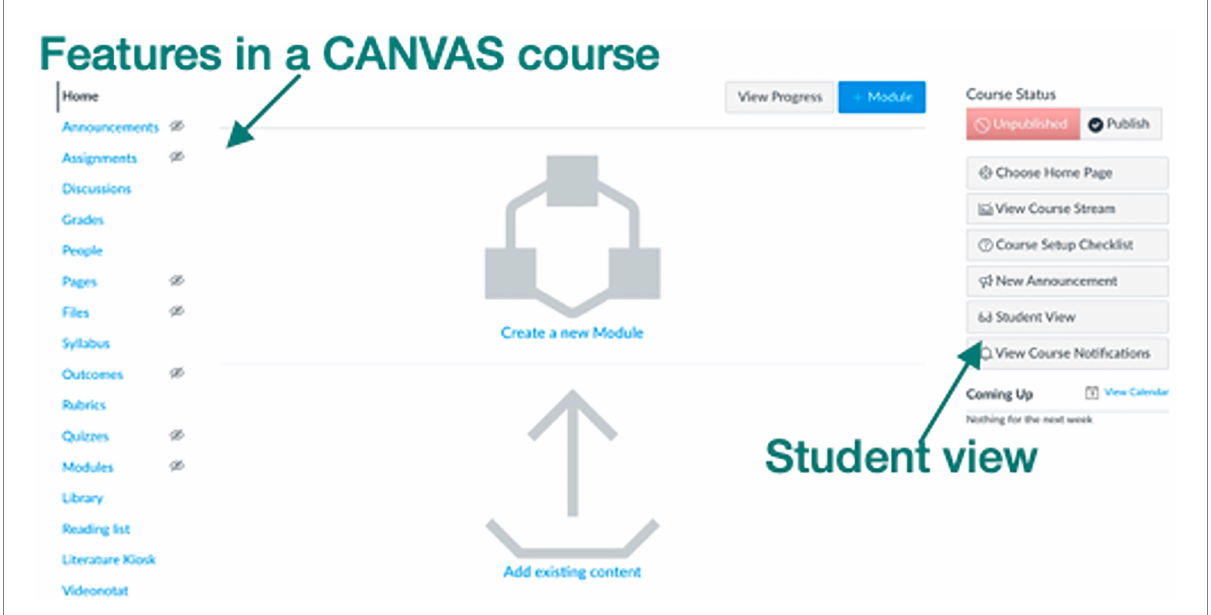
FIGURE 2 Screenshot of the teacher view in Canvas with the list of